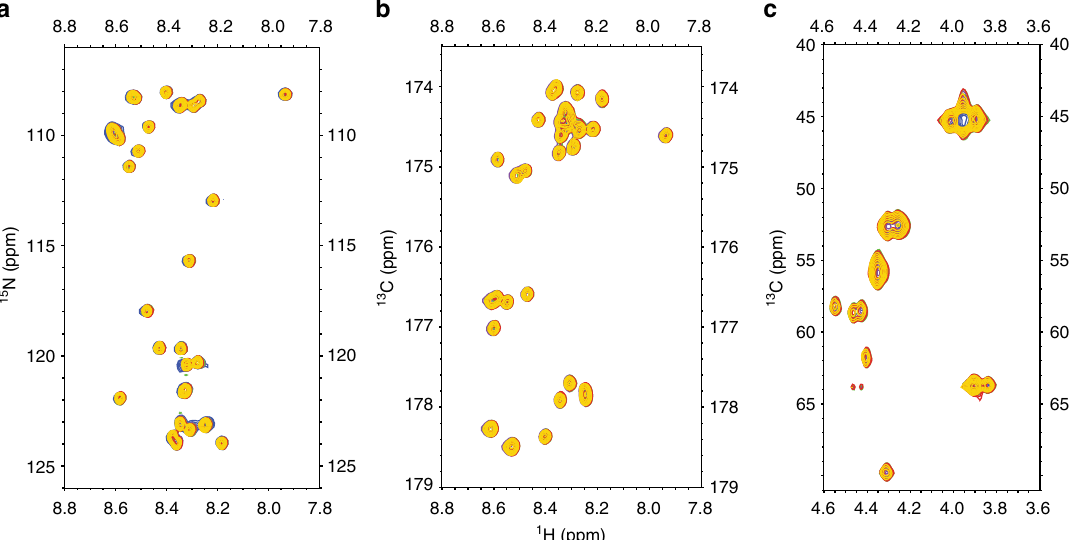
Fig. 4 No conformational changes observed in the repetitive domain at an acidic pH. Neither chemical shift changes nor line broadening effects were observed in the repetitive domain (15-mer) in the pH range from 7 to 2.6 at 10 °C. a Overlay of the 2D 1 H – 15 N HSQC spectra of the 15-mer. b Overlay of the 2D projection H(N)CO of the 15-mer, which provides the correlation with H N (i) – C ′ (i-1) . c Overlay of the 2D 1 H – 13 C HSQC spectra in the aliphatic region. Blue: pH 7; purple: pH 6; green: pH 5; red: pH 4; and yellow: pH